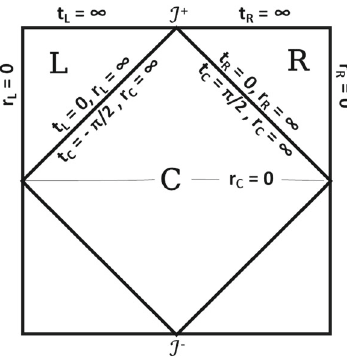
Fig. 1 The Penrose–Carter diagram of the hyperbolic de Sitter space- time, depicting three causally disconnected regions R , C and L , e.g. [8]. Any t = const . hypersurface in R or L are 3-hyperboloids. R and L are superhorizon separated by the intermediate region C . One thus obtains a natural set up to investigate long range quantum correlations between R and L . We are only concerned about the expanding R and L regions